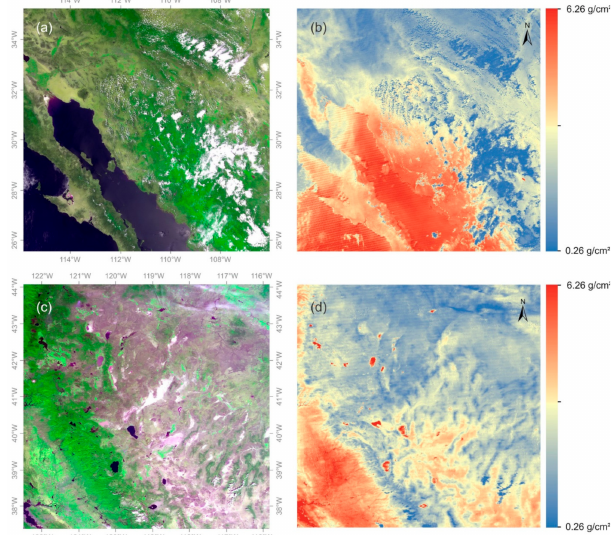
Figure 5. An example of PWV retrievals from FY-3D MERSI-2 NIR channels. The left panel shows a set of the true color images of FY-3D covering di ff erent kinds of land covers over North America. The right panel shows the water vapor images derived from the proposed algorithm. The FY-3D MERSI-2 scenes were acquired on ( a , b ) 12 August 2019, ( c , d ) 25 September 2019. The color ramp shows water vapor intensity from the lowest (blue) to highest